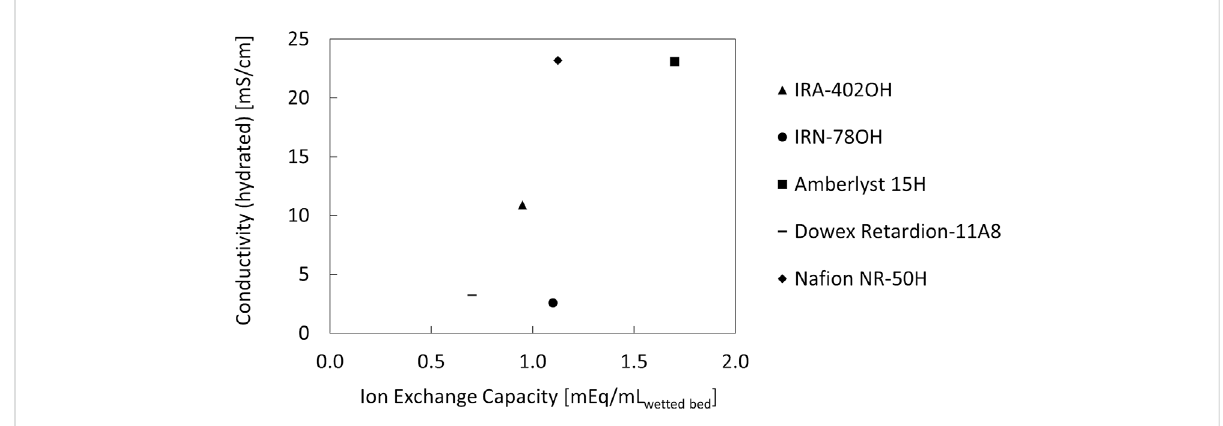
FIGURE 4 Conductivity of hydrated ion exchange resin beads, measured using electrochemical impedance spectroscopy.